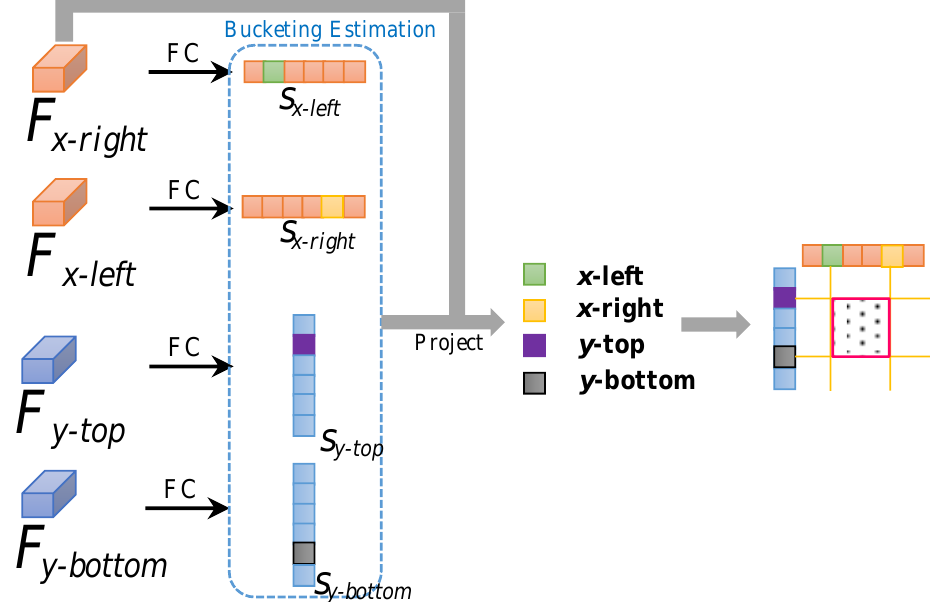
Figure 14. Implementation of the boundary bucketing coarse localization (BBCL) used in BABP- Block.